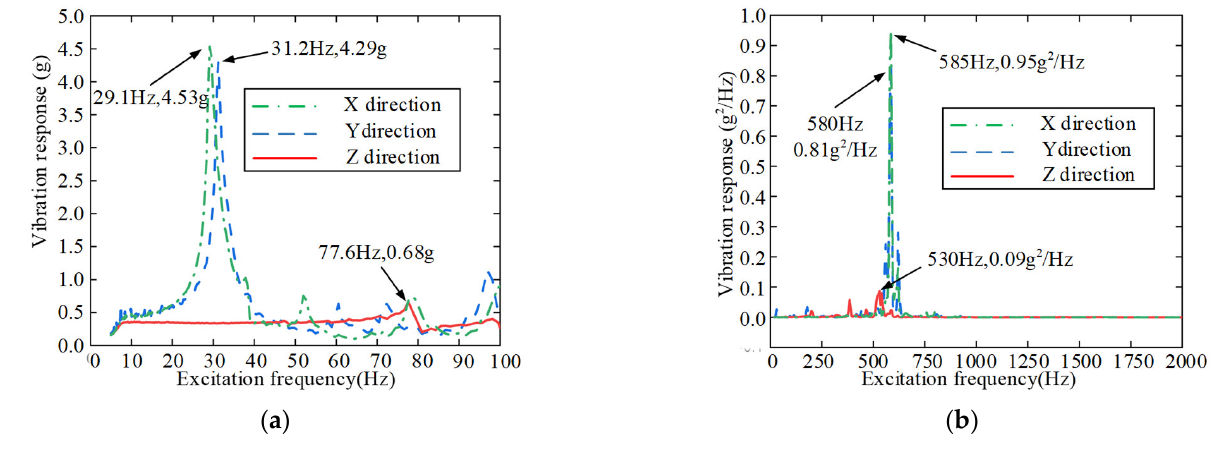
Figure 17. Vibration test results: ( a ) Sinusoidal vibration; ( b ) Random vibration. Table 2. Random vibration test conditions for system compression state.